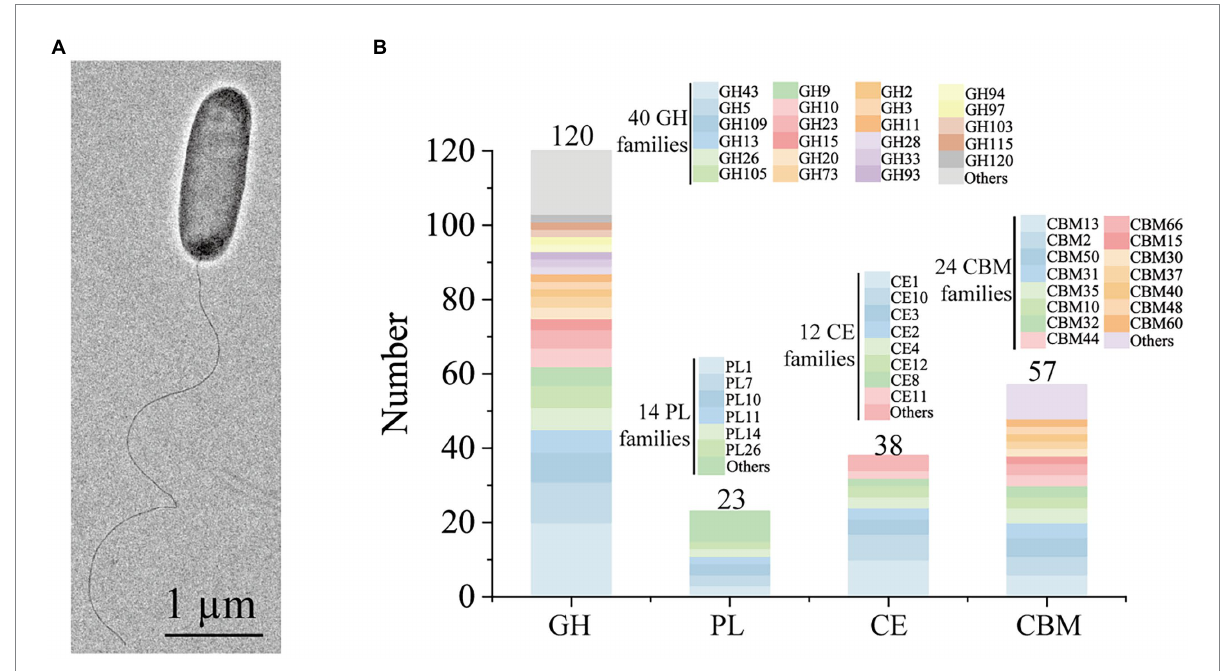
FIGURE 2 Morphological and genomic analysis of strain HB14 T possessing strong polysaccharide degradation capabilities. (A) Cell morphological observation of strain HB14 T by transmission electron micrograph. Strain HB14 T cells for observation were incubated on MAC at 30 ° C for 3 days. (B) Quantification of the carbohydrate-active enzymes (CAZymes) and their family classifications encoded by the genome of strain HB14 T . GH, glycoside hydrolase; PL, polysaccharide lyase; CE, carbohydrate esterase; CBM, carbohydrate-binding